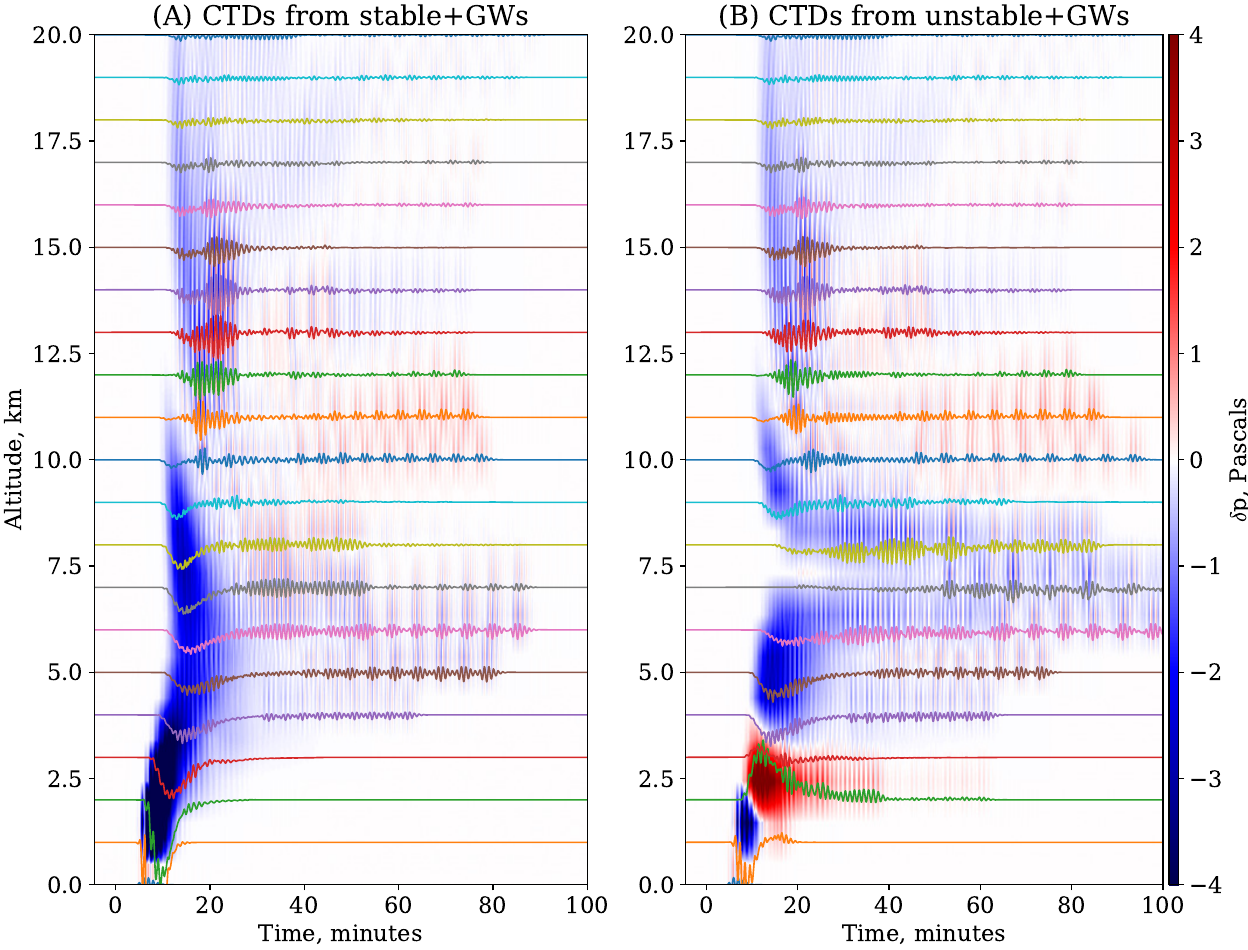
Figure 5. Vertical Travel Time diagram above the epicenter: It shows the CTDs from the stable GWs case and unstable GWs case in ( A , B ) respectively. CTDs defined as expression (6) is plotted in two types of format: as line plot at each height and as color pixmap. For better visualization, CTDs in line plot is multiplied by factor